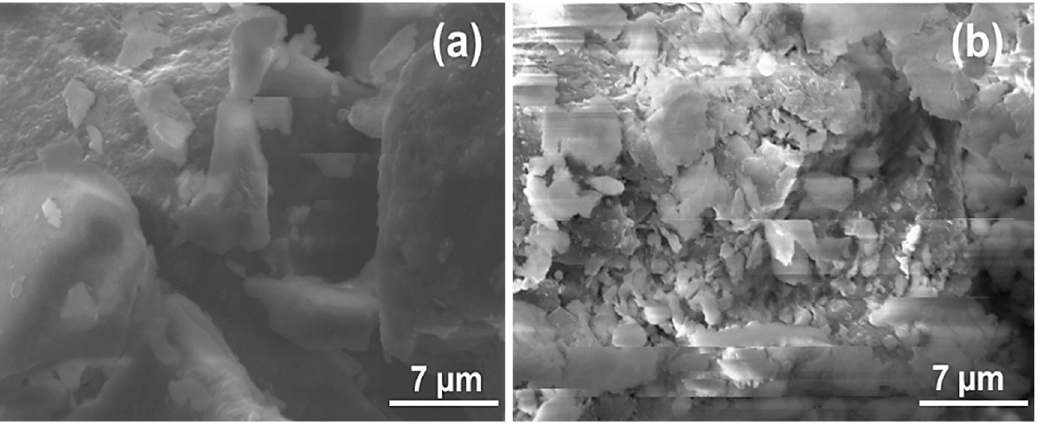
Figure 3. Scanning electronic microscopy images of unmodified La ( a ) and amino-functionalized laponite LaNH 2 ( b ).